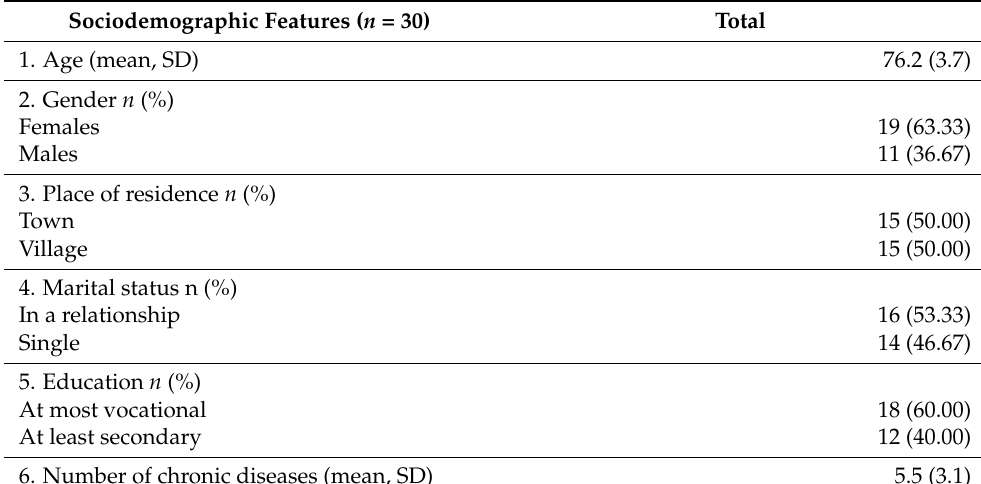
Table 1. The structure of the study group in the qualitative